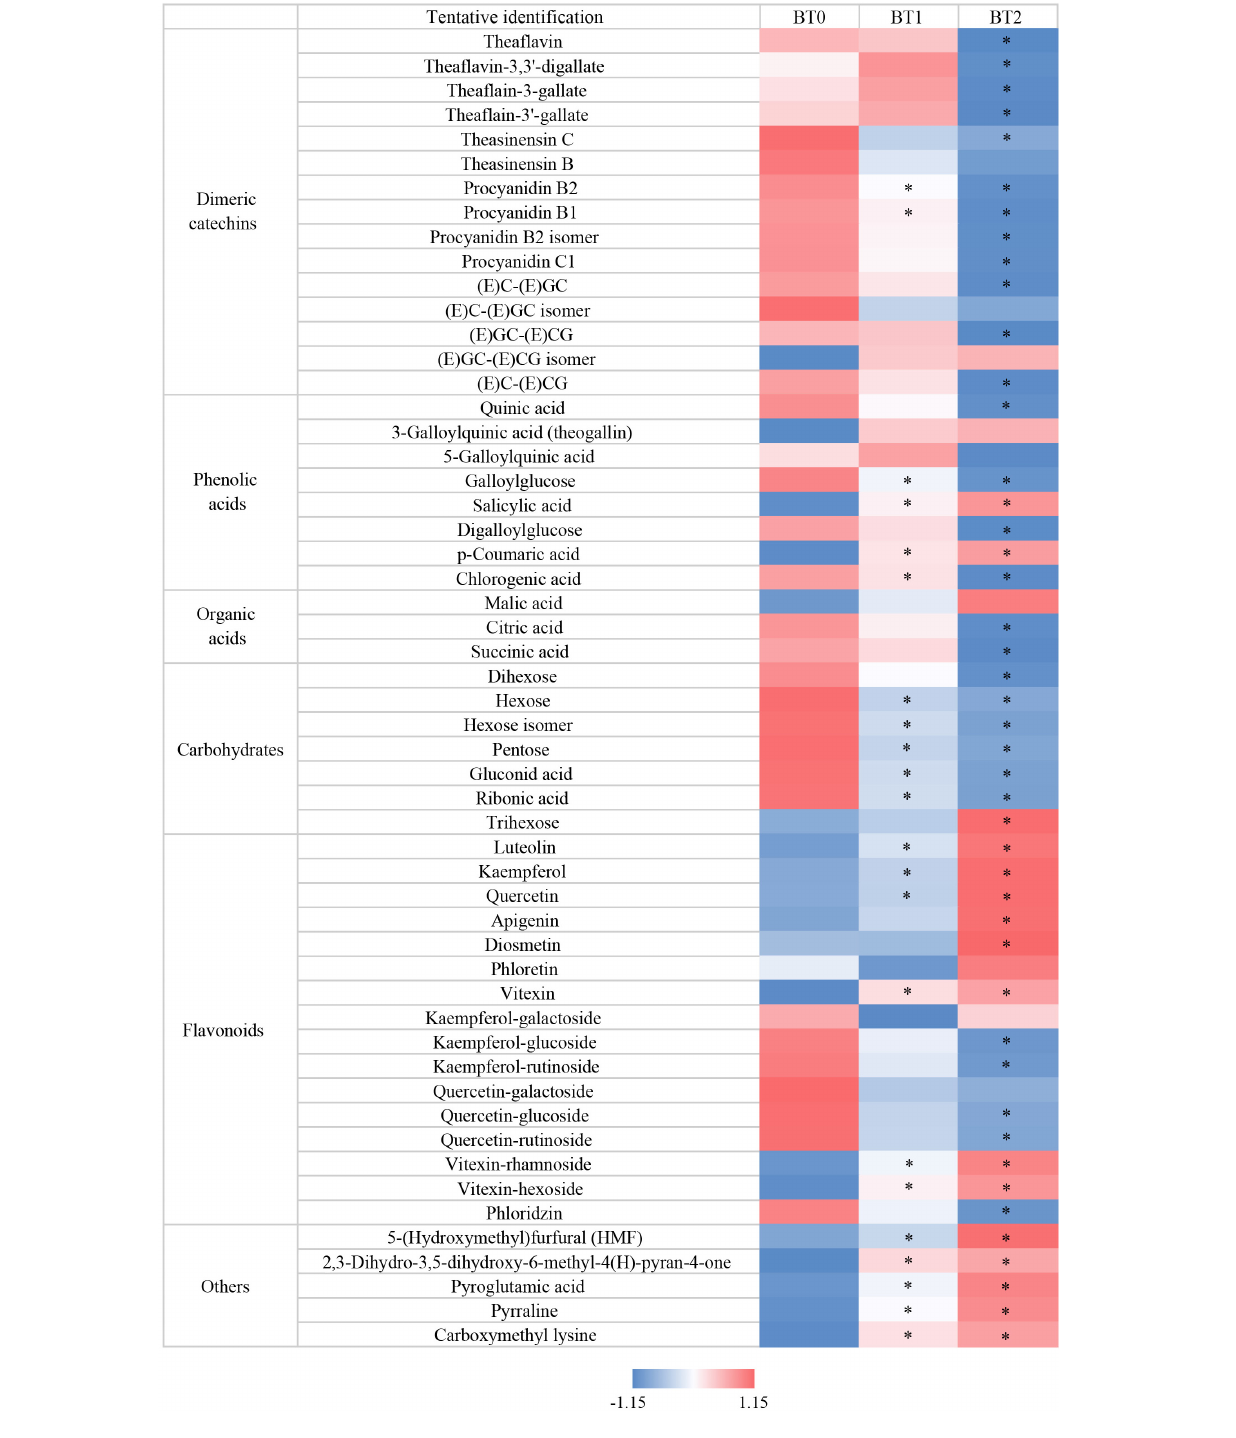
dimeric catechins (e.g., theasinensins and procyanidins) were reduced after baking ( Figure 2 ). In details, about 30% of TFs, 10% of theasinensins, and 30% of procyanidins were lost after